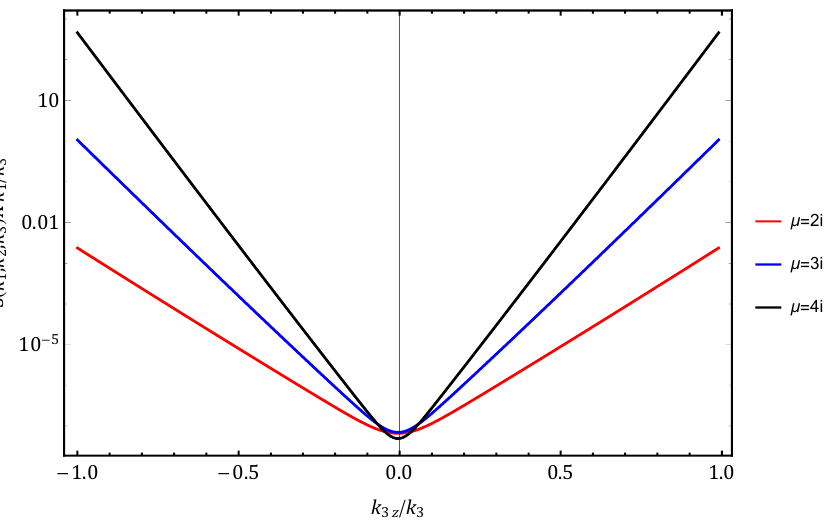
Figure 9 . This (cid:12)gure shows the ampli(cid:12)ed shape function S ( k angular dependence of the soft momentum k When the orientation is aligned to the orientation of the (cid:12)eld, the amplitude of the bispectrum is much larger. At the orientation perpendicular to the (cid:12)eld’s orientation, although the electric (cid:12)eld strength is strong, Schwinger e(cid:11)ect is weak and the e(cid:11)ective mass is large enough to suppress the bispectrum. At the orientation parallel to the orientation of the (cid:12)eld, the Schwinger e(cid:11)ect is strong enough to generate a bispectrum of large